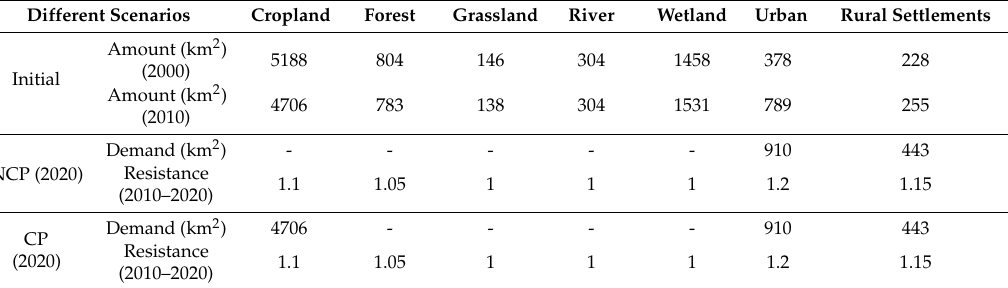
Table 1. The parameters set for land use